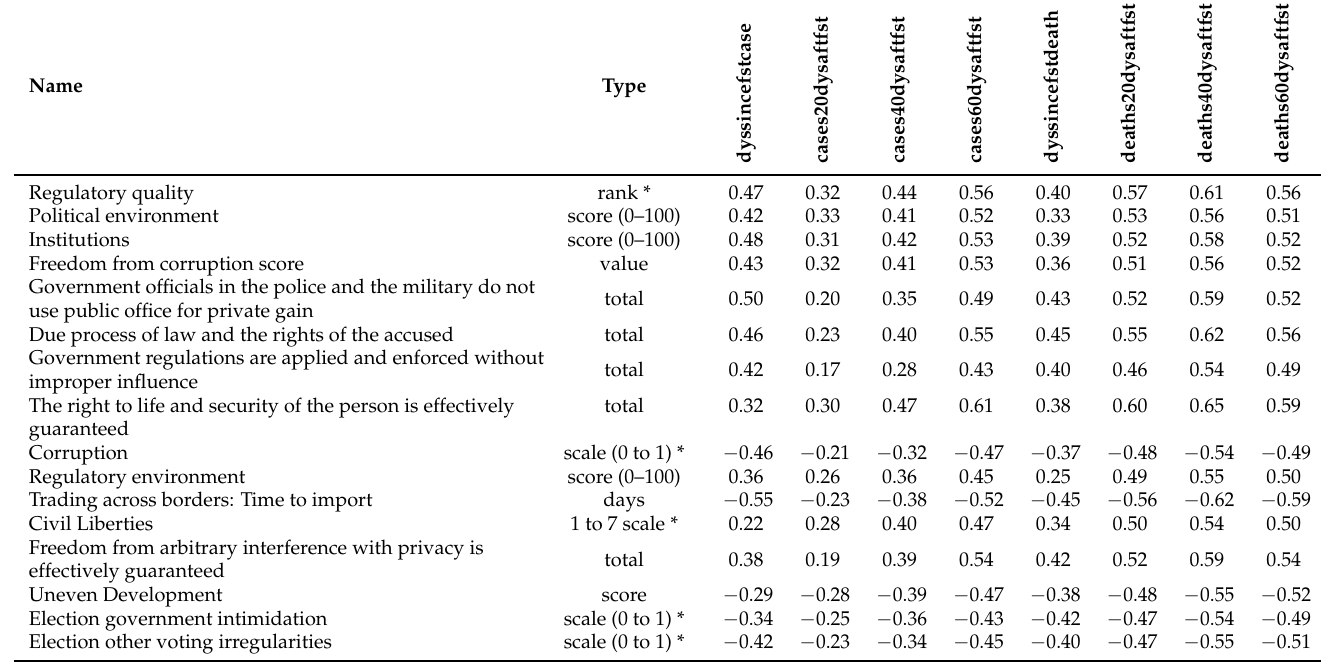
Table A4. Standalone correlations in the regulation and corruption community. Spearman rank correlations between COVID- 19 variables and indicators of the regulation and corruption community in the worldwide dataset.